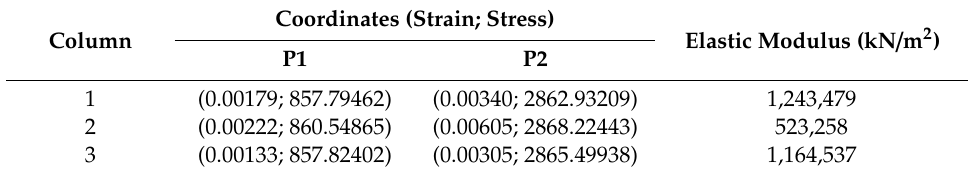
Table 11. Elastic modulus for the grouted columns, obtained from the linear part of stress–strain curves between Points P1 and P2